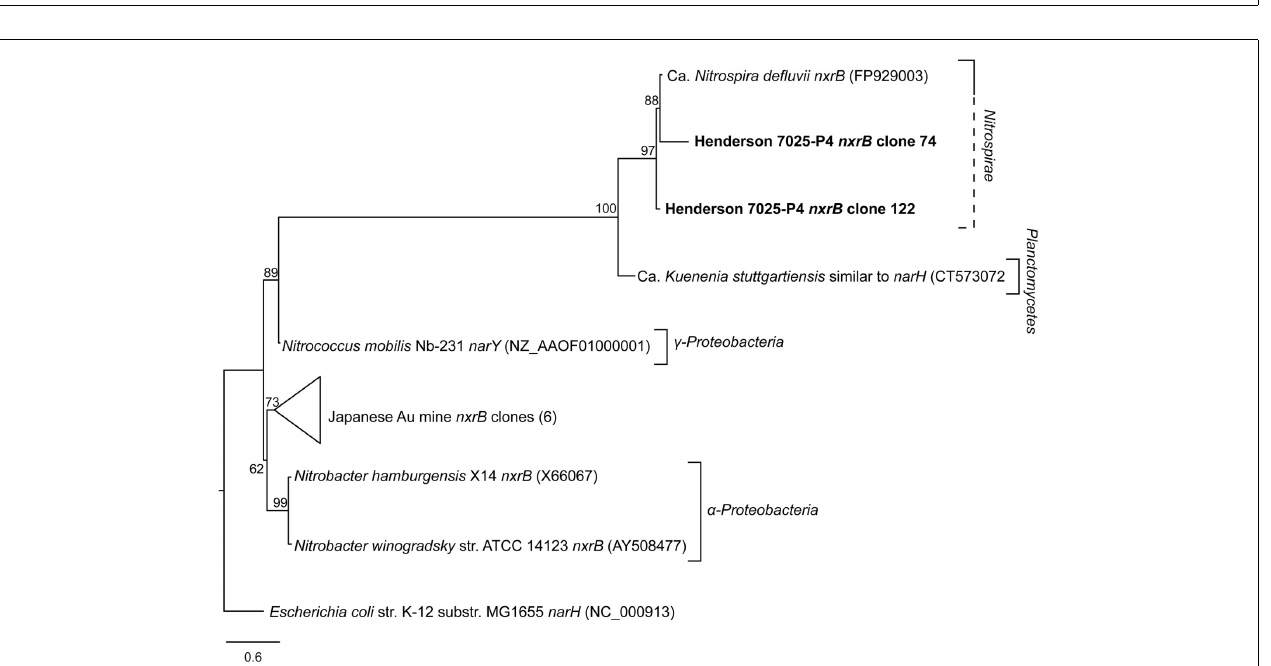
FIGURE 3 | Schematic representation of the best-scoring maximum-likelihood tree generated by an alignment of nucleotide sequences corresponding to the archaeal amoA genes amplified from this study (bold) and other environments and pure cultures. The